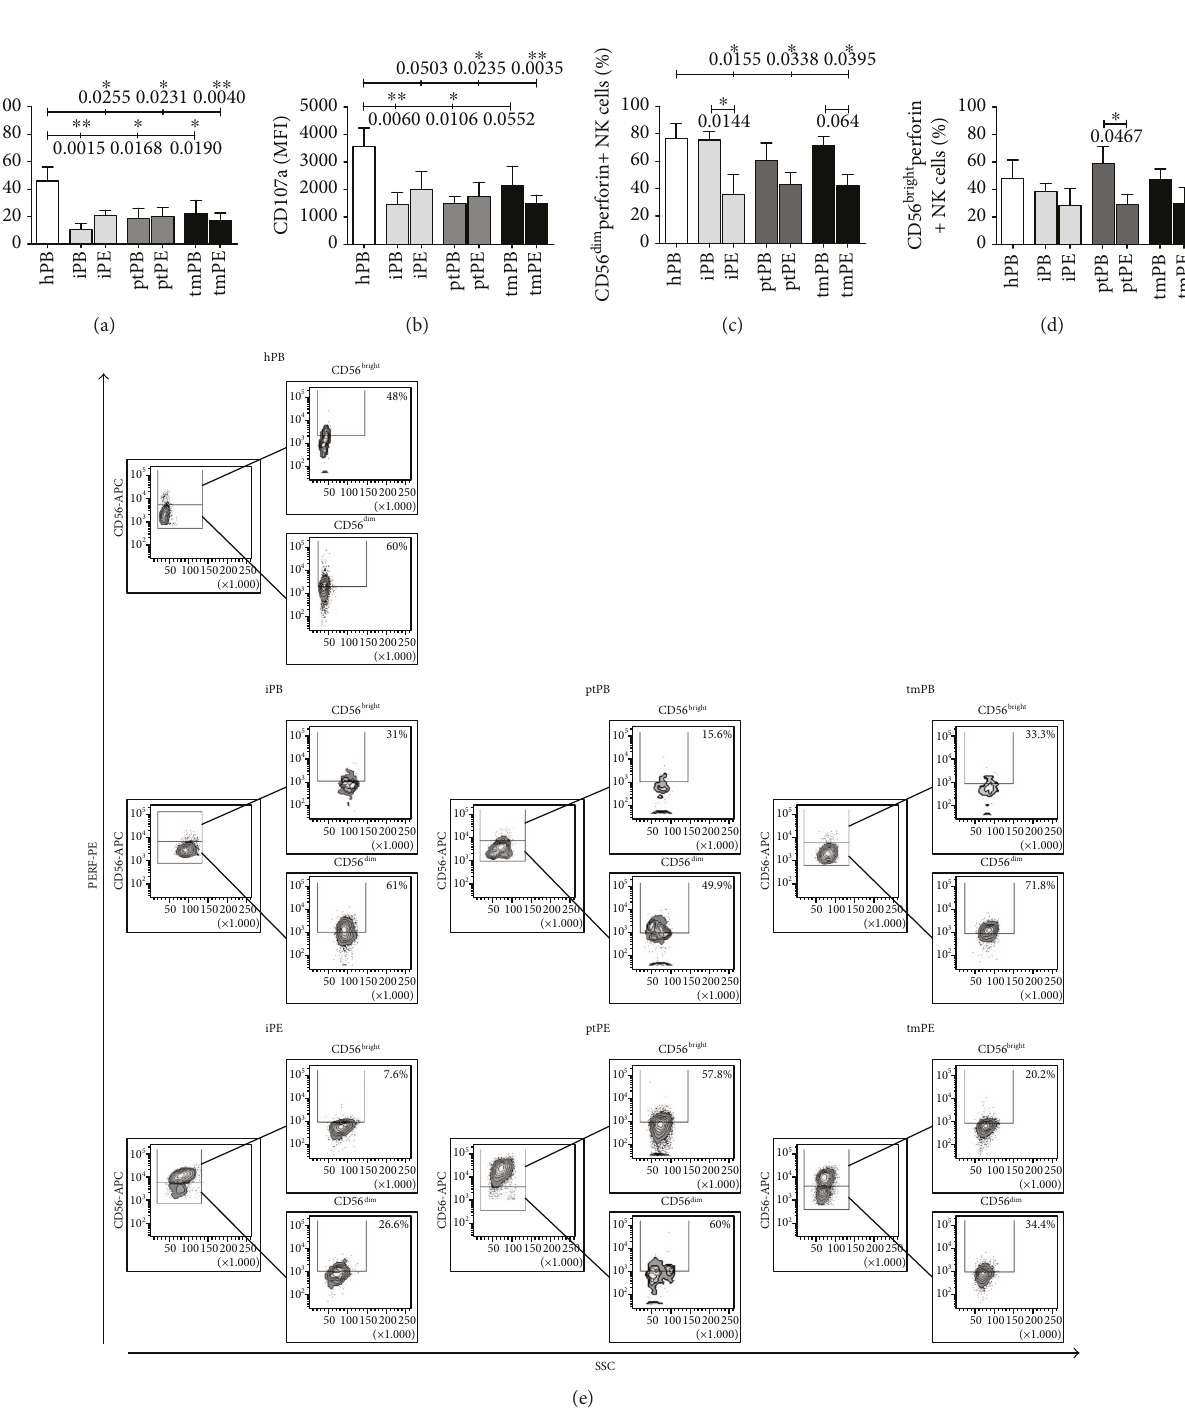
Figure 5: Modulation of degranulation (CD107a) and perforin secretion in NK cell subsets. Flow cytometric analysis for CD107a surface marker showed a downregulation of CD107a expression on PB-NK and PE-NK cells in terms of percentage of positive cells (a) and mean intensity of fl uorescence (MFI) (b) that correlated with a signi fi cant decrease of the percentage of perforin + NK cells, both in CD56 dim and CD56 bright subsets in iPE and ptPE (c, d) after exposure to target K562 cells. Representative dot plots of perforin expression in healthy donors and patients with in fl ammatory, primary, and metastatic tumor PE are shown, respectively (e). Data are shown as mean ± SEM of 34 samples; ∗ p < 0 05 and ∗∗ p < 0 01 ( p values are